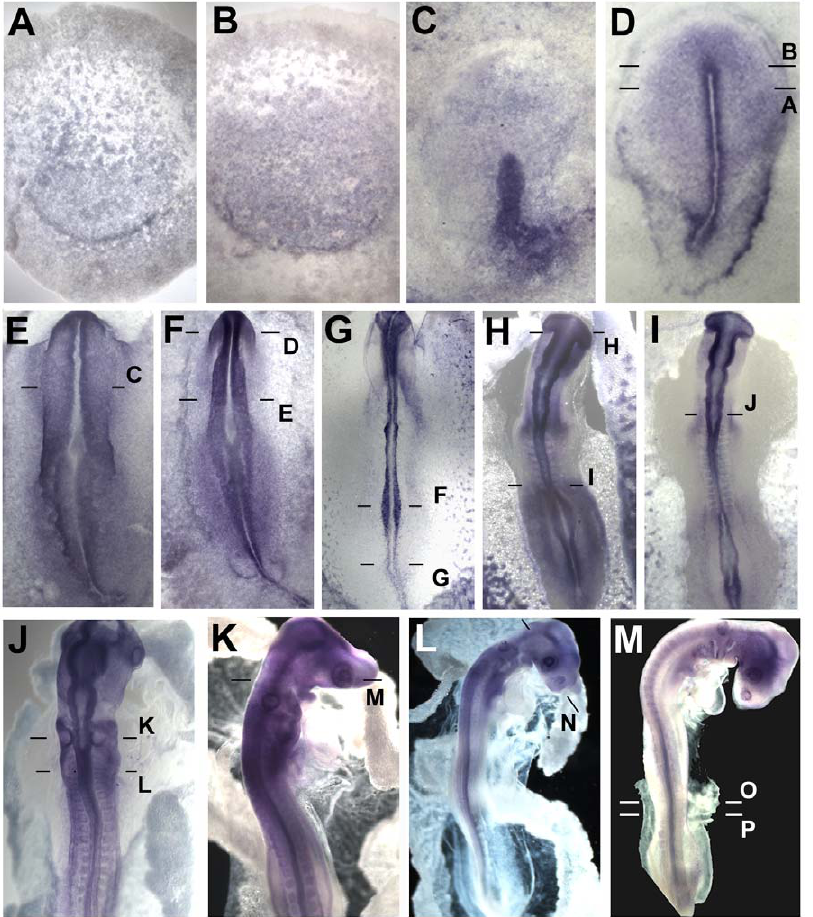
Figure 5. Expression of Asterix during development. Embryos at stages XI (A), XII (B), 3 (C), 4 + (D), 6 (E), 7 (F), 9 (G), 10 (H), 11 (I), 14 (J), 16 (K), 17 (L) and 18 (M) are shown. The horizontal lines and letters refer to the levels at which sections in Fig. 4 were taken.